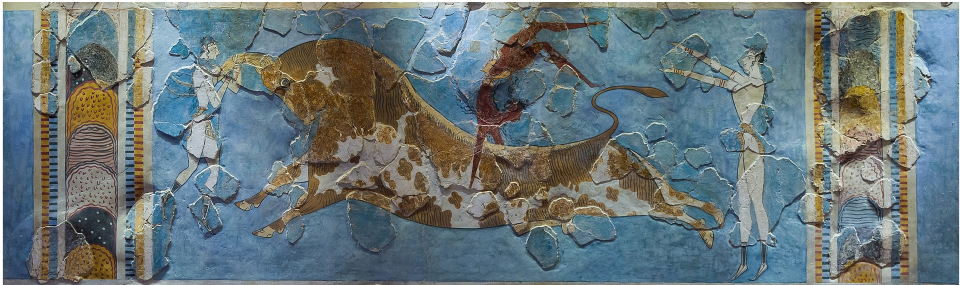
Figure 14. Minoan fresco in Knossos palace, c. 1600-1450 BC [197].